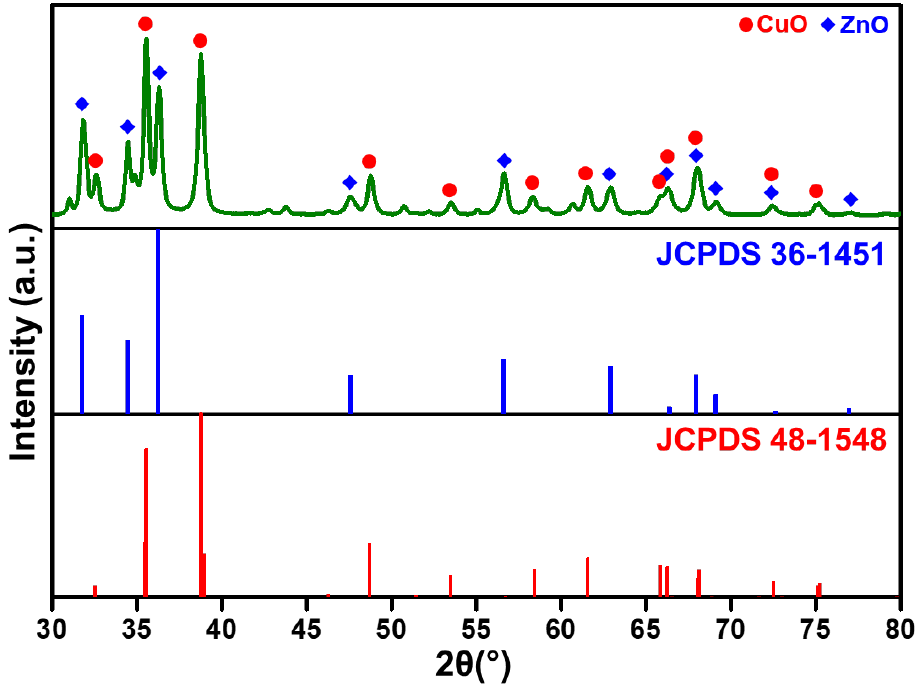
Figure 2. Comparison of XRD pattern of Cu x Zn y O mixed metal oxide (top) with standard database JCPDS 36-1451 (middle) and JCPDS 48-1548 (bottom).